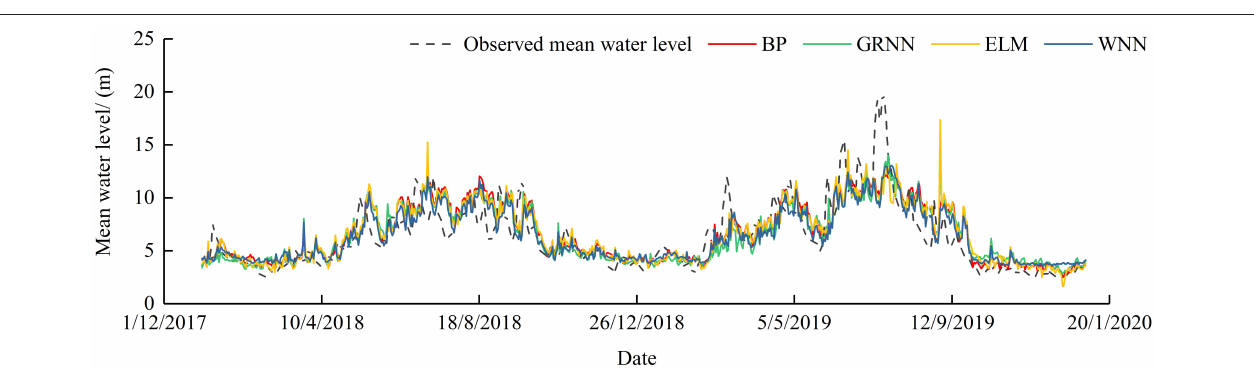
FIGURE 5 | Hydrographs of observed and simulated mean water